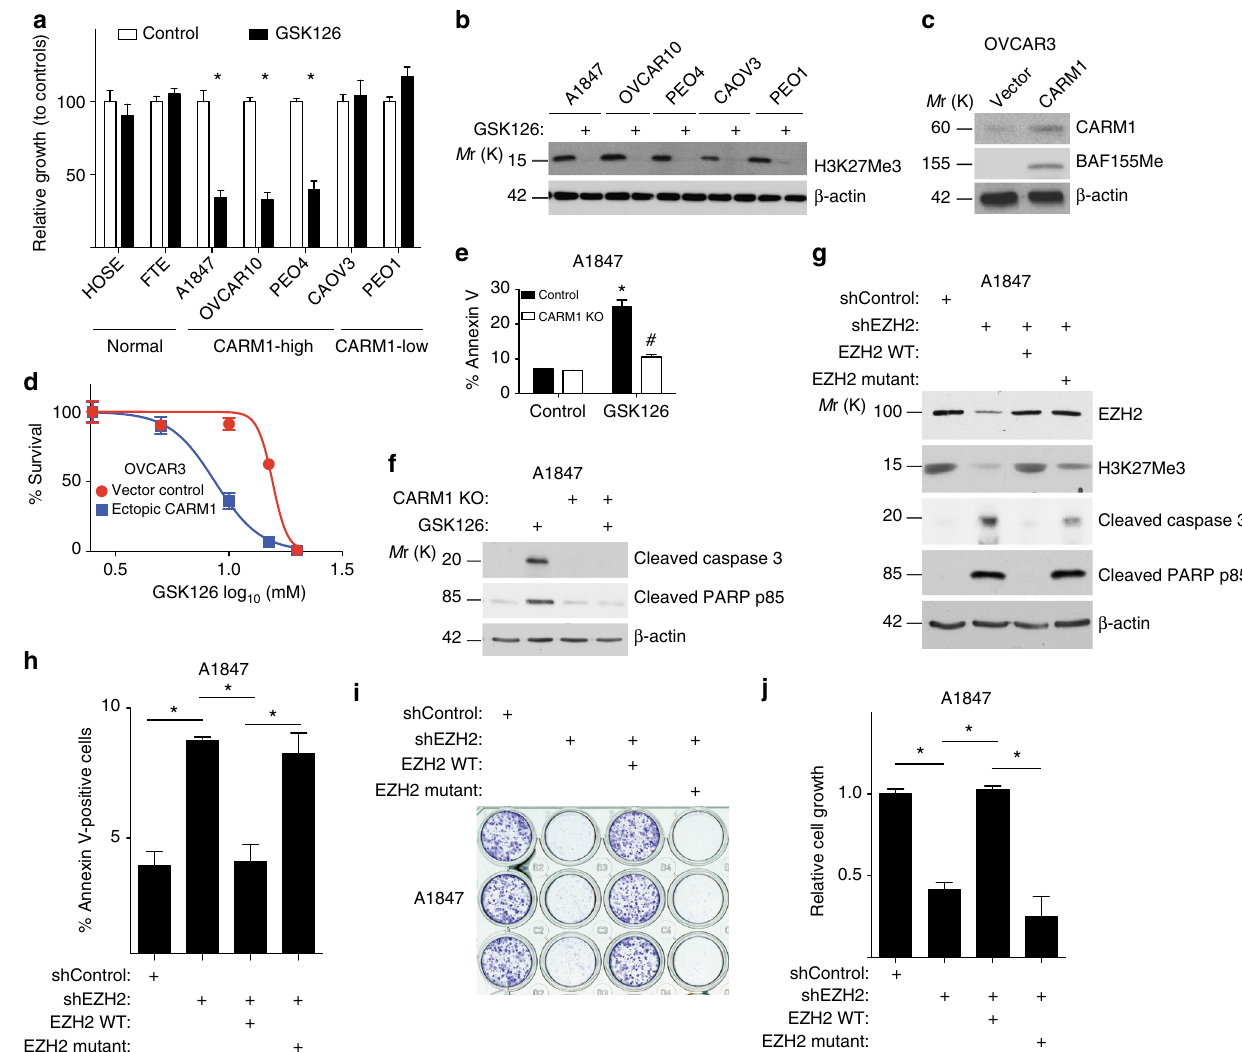
Fig. 2 The selectivity against CARM1 by EZH2 inhibition correlates with apoptosis induction in a methyltransferase activity-dependent manner. a Relative growth of the indicated HOSE, FTE, and EOC cancer cell lines with high or low CARM1 expression treated with 10 μ M GSK126 or vehicle in a colony formation assay as determined by NIH ImageJ quanti fi cation. b Expression of H3K27Me3 in the indicated EOC cell lines with high or low CARM1 expression treated with or without 10 μ M GSK126. Expression of β -actin was used as a loading control. c , d Expression of CARM1, BAF155Me, and β -actin in OVCAR3 cells with ectopic CARM1 or control ( c ). GSK126 dose response curves of the indicated cells were determined by colony formation assay ( d ). Mean of three independent experiments with SEM. e Control parental and CARM1 knockout A1847 cells were treated with 10 μ M GSK126 or vehicle DMSO control for 7 days. Percentage of Annexin V-positive apoptotic cells was quanti fi ed. * P < 0.001 and # P > 0.05. f Apoptosis markers cleaved caspase 3 and cleaved PARP p85 in parental and CARM1 knockout A1847 cells treated with 10 μ M GSK126 for 7 days. Expression of β -actin was used as a loading control. g – j CARM1-high A1847 cells were infected with a lentivirus encoding shEZH2 targeting the 3 ′ untranslated region (UTR) of the human EZH2 gene together with a retrovirus encoding wild-type EZH2 (WT) or a SET domain-deleted EZH2 mutant (EZH2 Δ SET). Drug-selected cells were examined for EZH2, H3K27Me3, apoptosis markers cleaved caspase 3 and cleaved PARP p85, and a loading control ( β -actin) by immunoblot ( g ), quanti fi ed for Annexin V-positive apoptotic cells by FACS ( h ), subjected to a colony formation assay ( i ), and quanti fi ed for the relative cell growth based on colony formation using NIH ImageJ ( j ). * P < 0.01. Means of three independent experiments with SEM. P -values are from two-tailed t H3K27Me3 target genes among the 2084 genes upregulated at least 3-fold in CARM1 KO cells compared with parental controls ( P = 1.5 × 10 − 136 , determined by hypergeometric test) (Supple- mentary Fig. 3c). We cross-referenced the list of 218 direct EZH2/ H3K27Me3 target genes with 528 TCGA high-grade serous ovarian carcinomas gene expression pro fi les and identi fi ed genes that negatively correlated with CARM1 expression in these cases.